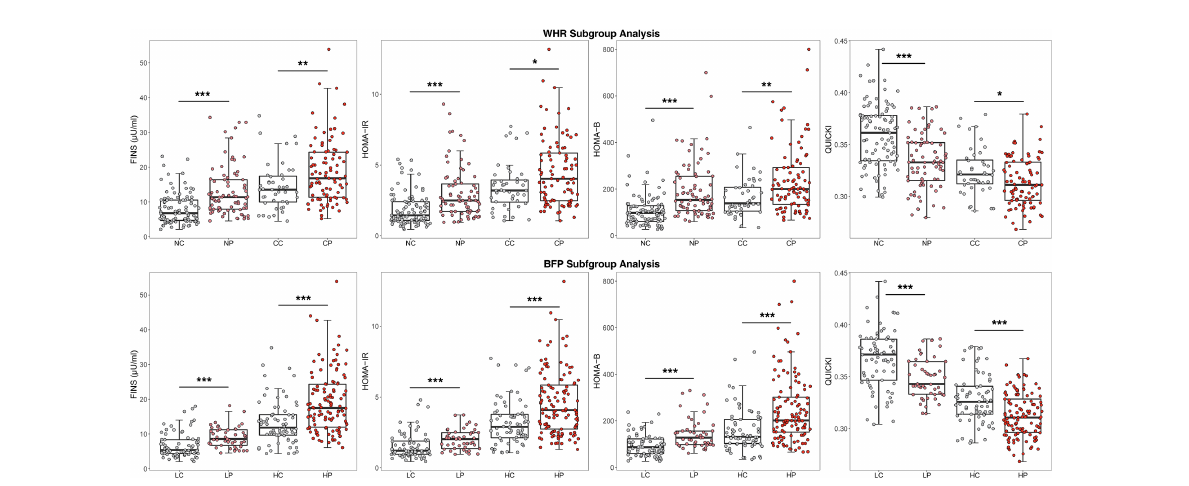
FIGURE 1 Comparison of glucose metabolism indicators after WHR and BFP strati fi cation a . a WHR, Waist-to-hip ratio; BFP, Body fat percentage; CP, Central obese PCOS group; CC, Central obese control group; NP, Non-central obese PCOS group; NC, Non-central obese control group; HP, High body fat percentage PCOS group; HC, High body fat percentage control group; LP, Low body fat percentage PCOS group; LC, Low body fat percentage control group; FINS, fasting insulin; HOMA-IR, homeostasis model assessment of insulin resistance; HOMA-B, Homeostasis model assessment of b -cell function; QUICKI, quantitative insulin sensitivity check index. * p < 0.05, ** p < 0.01, *** p < 0.001.